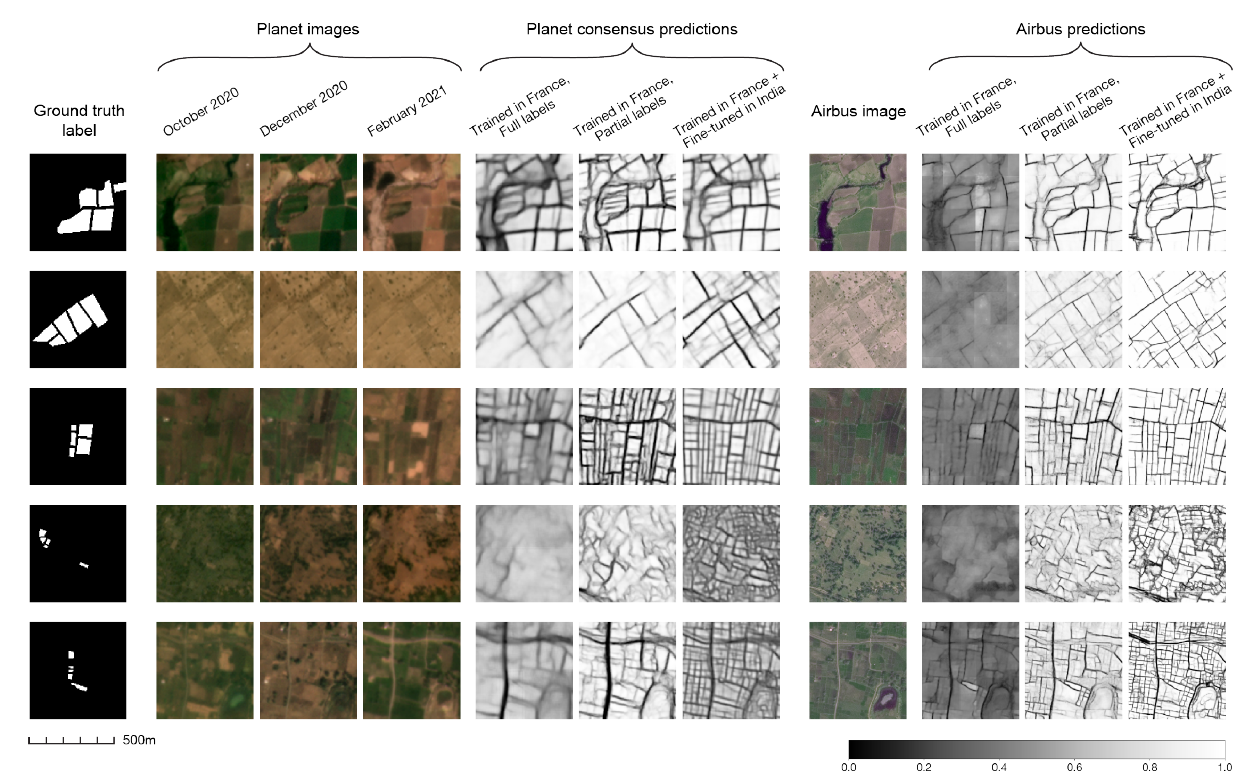
Figure 5. Example model predictions in India. We show the ground truth label, Planet Visual Basemap (PlanetScope) images for 3 months, Airbus OneAtlas Basemap (SPOT) images, and predic- tions using either Planet or Airbus images at five locations in India. Predictions are shown for three types of models: (1) trained only in France using full labels, (2) trained only in France using partial labels, and (3) pre-trained in France then fine-tuned in India using partial